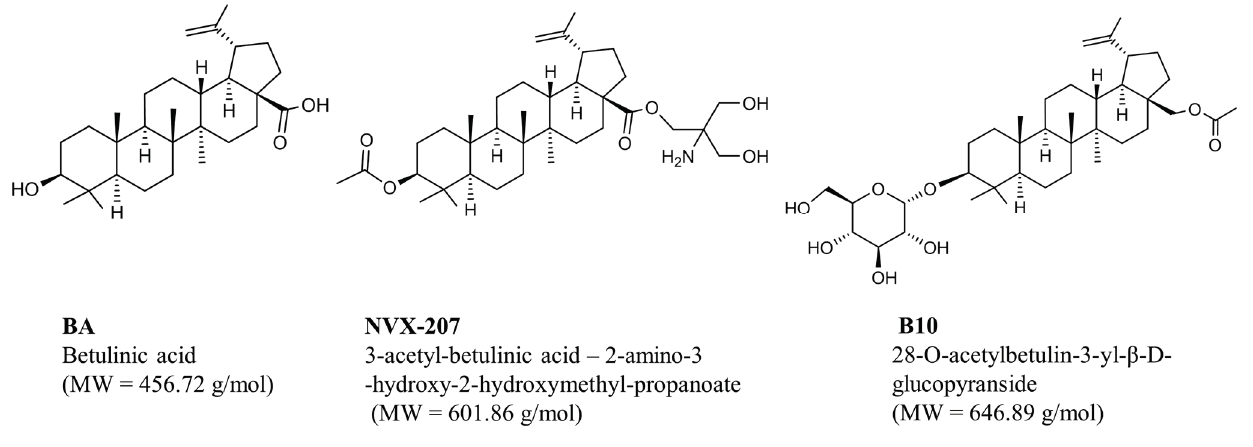
Figure 1. Structures of betulinic acid (BA), NVX-207 and